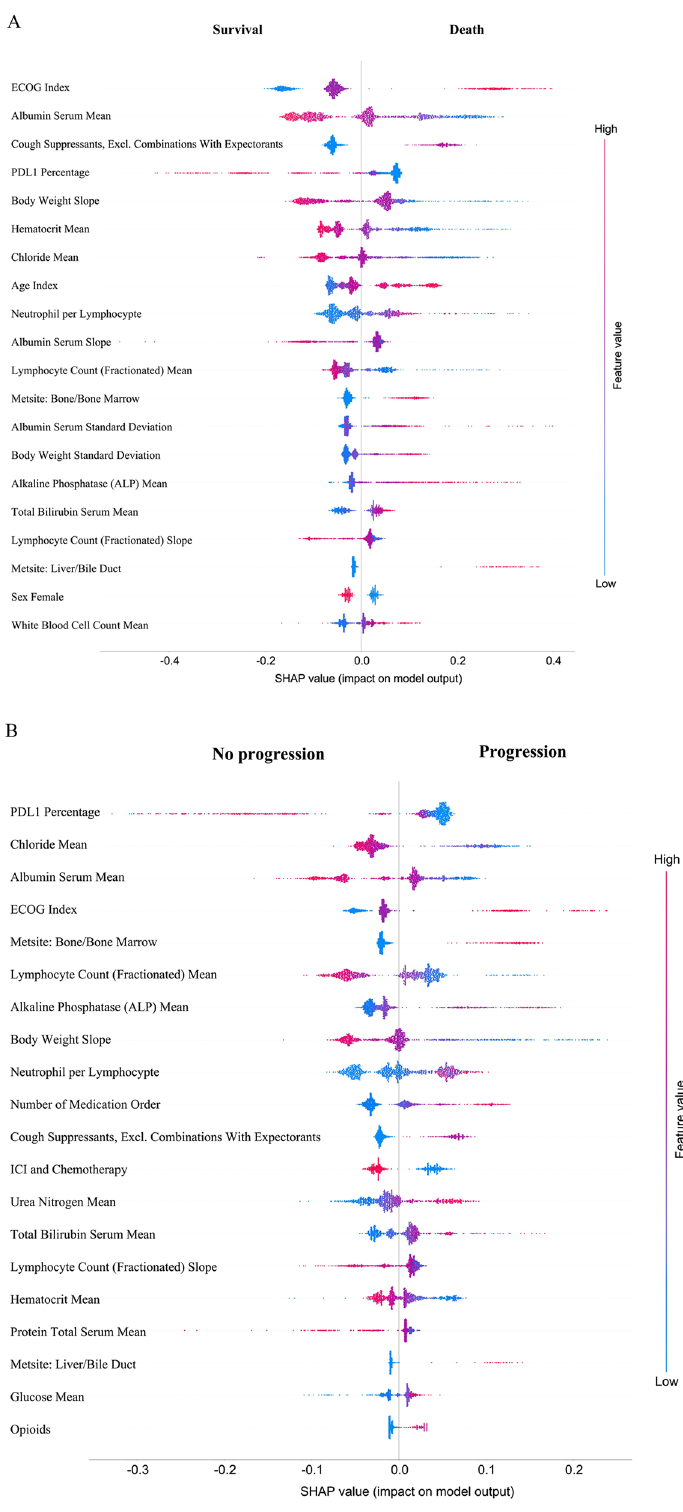
Figure 3. Summary plots for SHAP values. ( A ) Overall survival. ( B ) Progression-free survival. For each predictor, one point corresponds to a single patient, and the x-axis represents the impact of the feature on the model’s output for the specific patient. A positive SHAP value contributes to death or disease progression, while a negative value contributes to OS or PFS. Predictors are arranged along the y-axis based on their ranking: the higher the feature is positioned in the plot, the more significant it is in the model. ECOG, Eastern Cooperative Oncology Group; ICI, immune checkpoint inhibitor; PD-L1, programmed cell death-ligand 1; SHAP, SHapley Additive